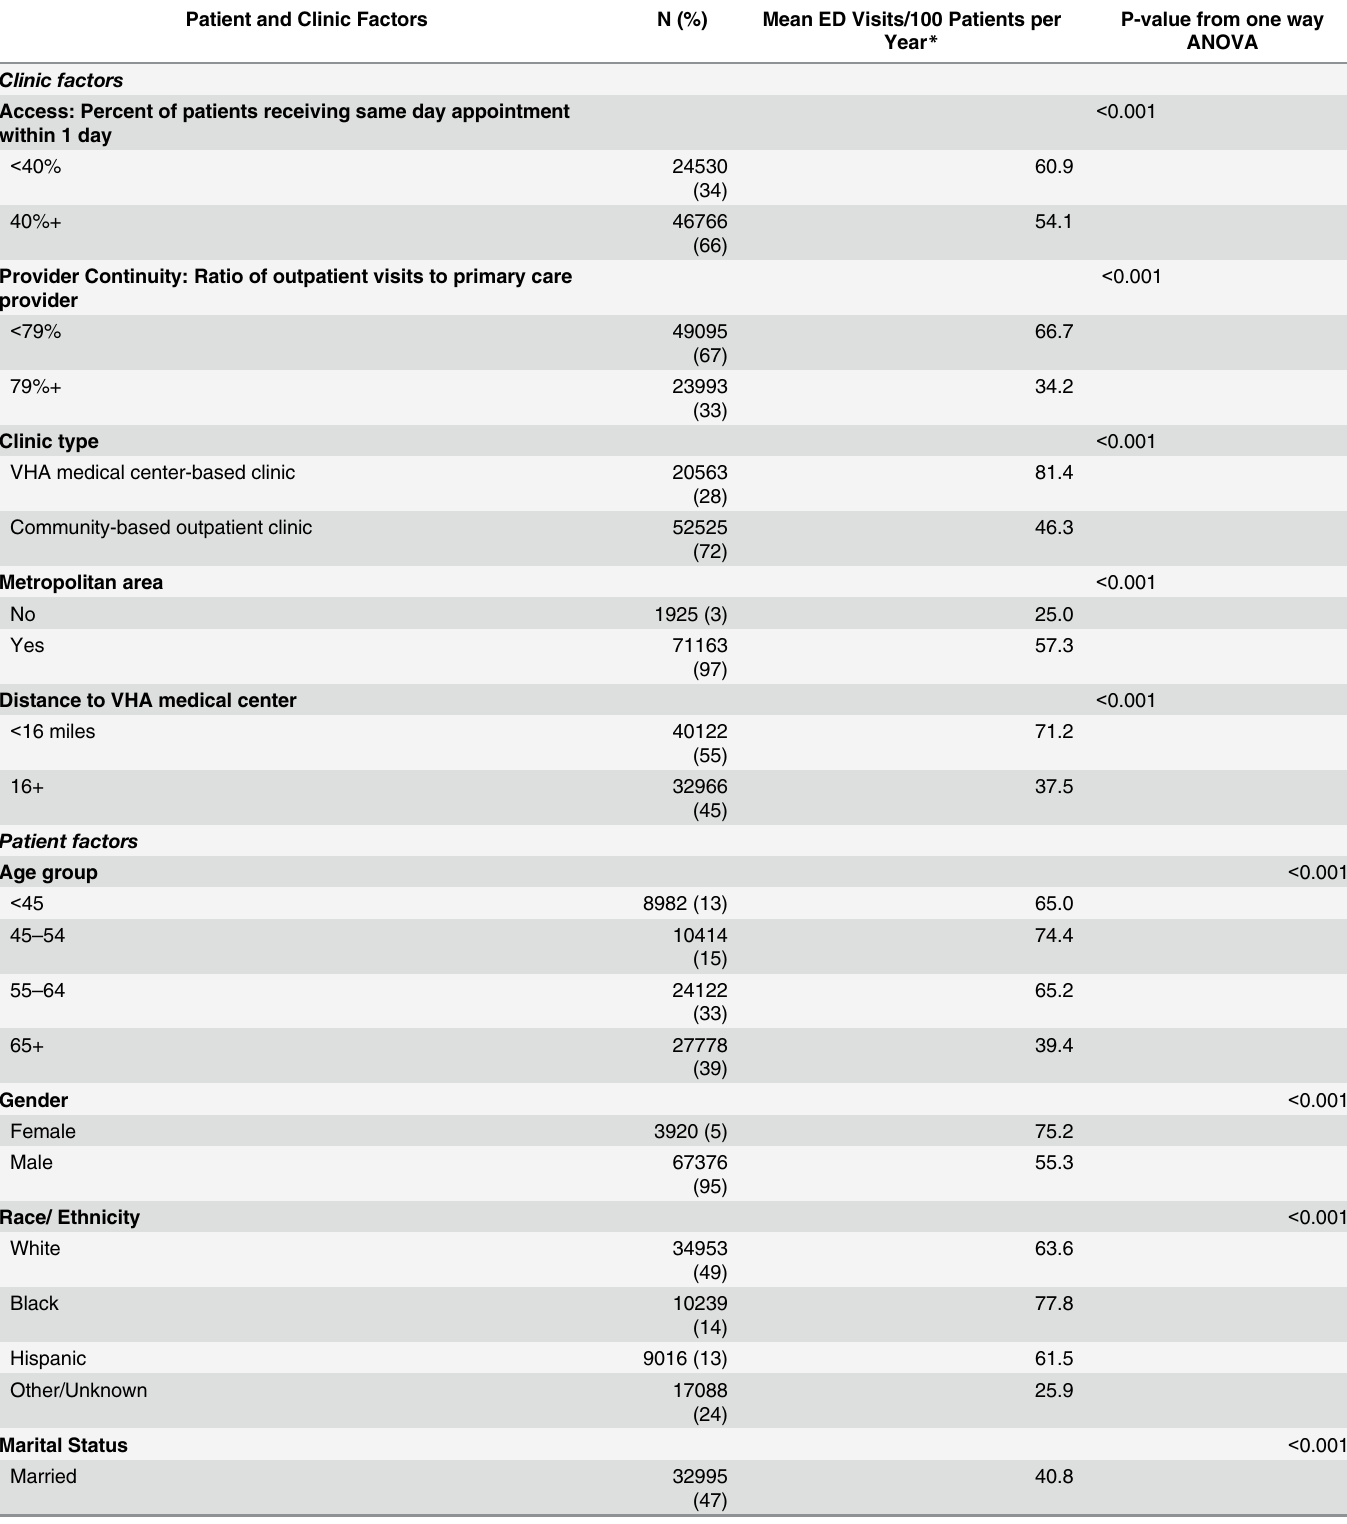
Table 3. Annual Rate of ED Visits by Patient and Clinic Characteristics FY2010-2012, N =